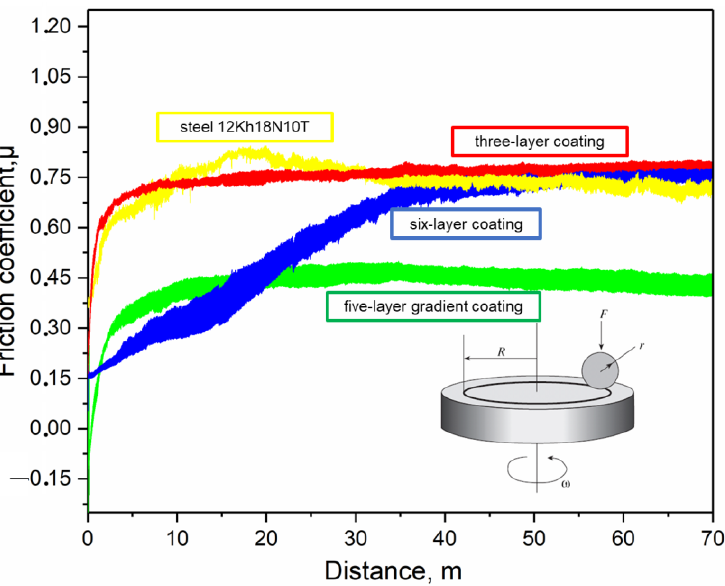
Figure 15. Dependence of the friction coefficient µ of the original steel and multilayer gradient coat- ings.